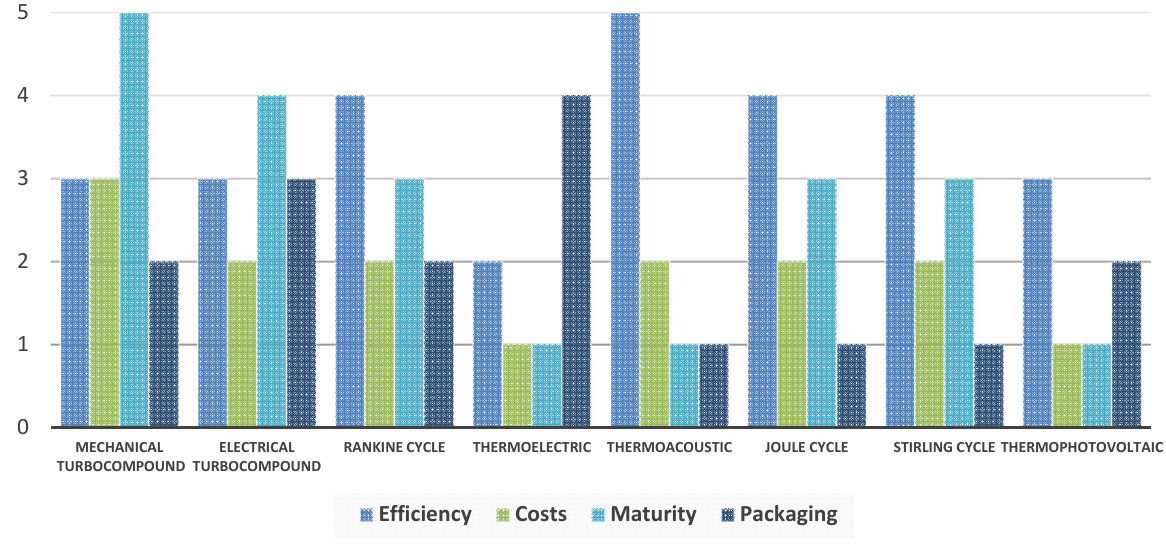
Figure 2. Performance indicators of each waste heat recovery technology for an automotive